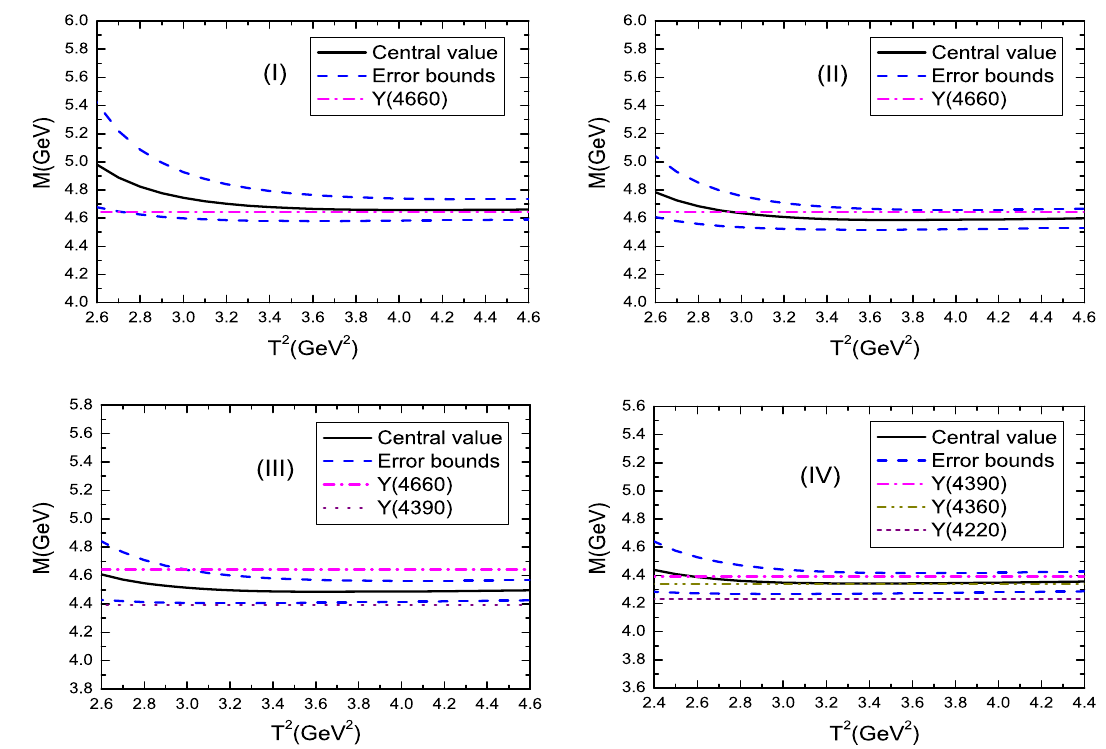
Fig. 1 The masses of the vector tetraquark states with variations of the Borel parameters T 2 , where the (I), (II), (III) and (IV) denote the currents J 1